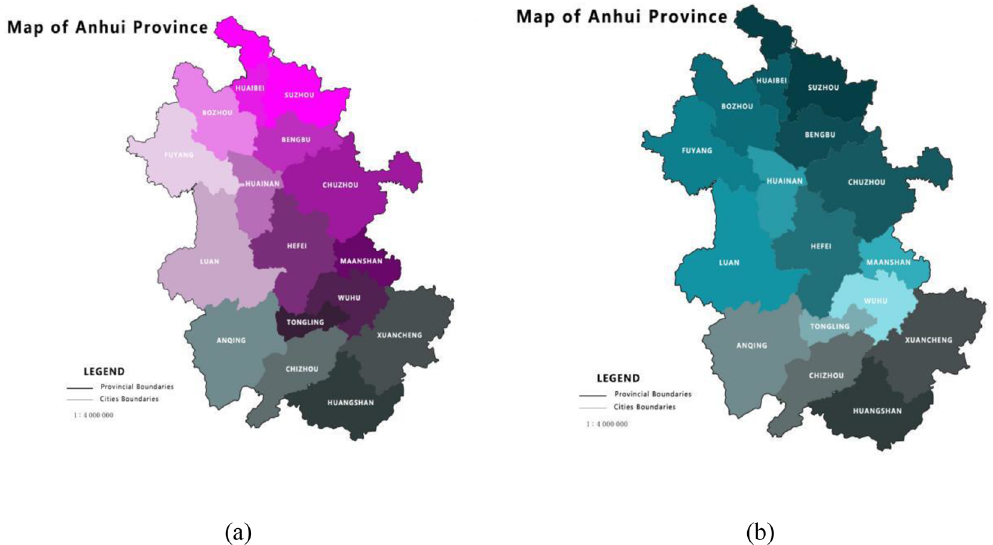
Figure 2. ( a ) The overall rural revitalization index level of Anhui Province in 2019; ( b ) The level of industrial prosperity in Anhui Province.